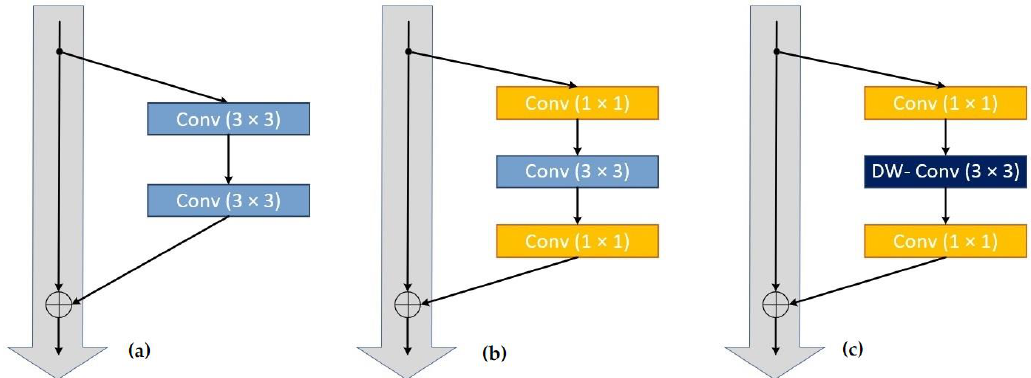
Figure 5. ( a ) Residual Projection, ( b ) Bottleneck Projection, ( c ) Depth-wise (DW) Bottleneck